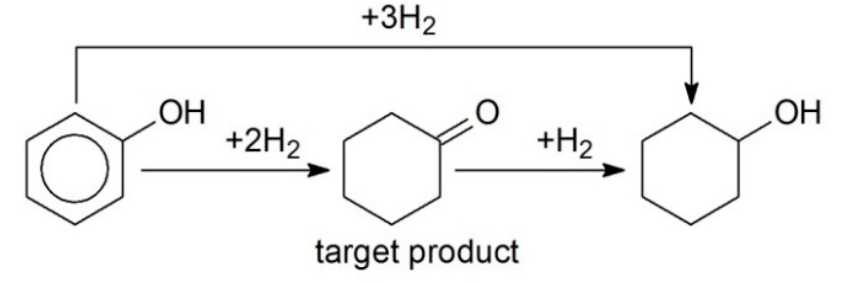
Figure 9. Scheme of selective hydrogenation of PL to CHN.